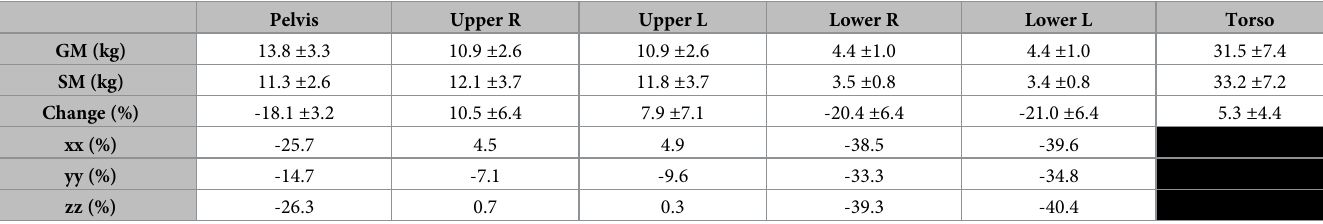
Table 1. Body segment mass and inertia changes between generic and subject-specific models.